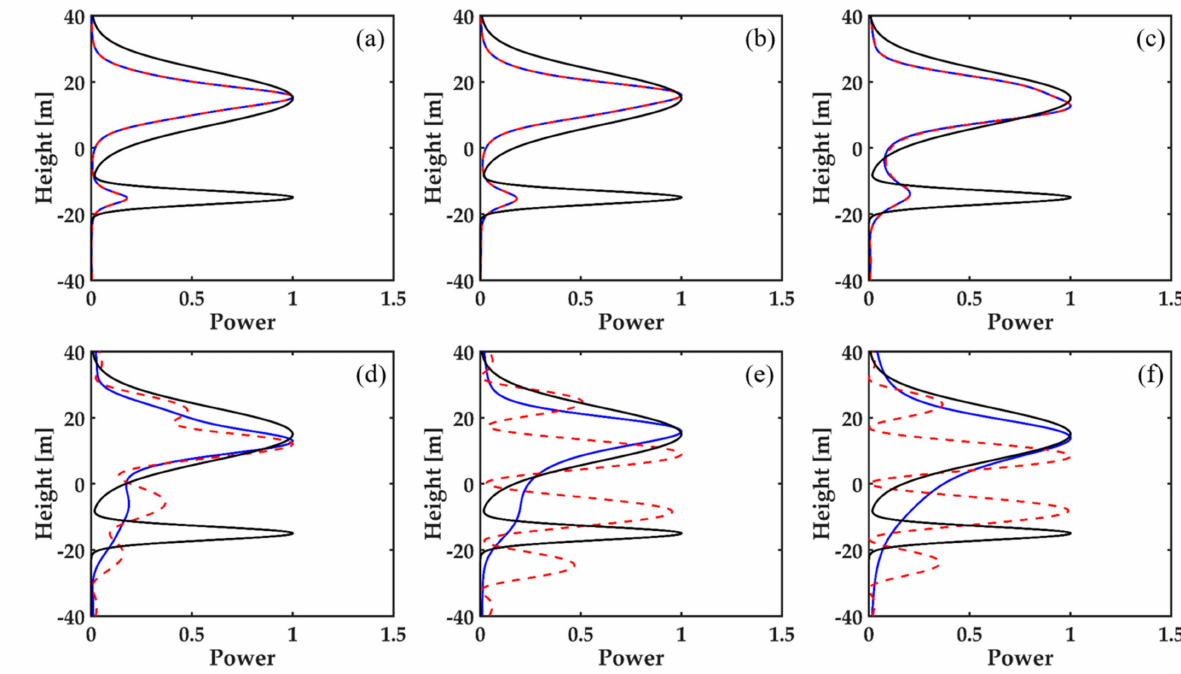
Figure 3. Reconstructed reflectivity profiles by the RIAA and IAA methods with different tomographic apertures in the second scattering scenario: ( a ) 30 m; ( b ) 25 m; ( c ) 20 m; ( d ) 15 m; ( e ) 10 m; ( f ) 5 m. The black solid lines are the true simulated reflectivity profiles. The blue solid lines are the reconstructed reflectivity profiles of RIAA. The red dotted lines are the reconstructed reflectivity profiles of